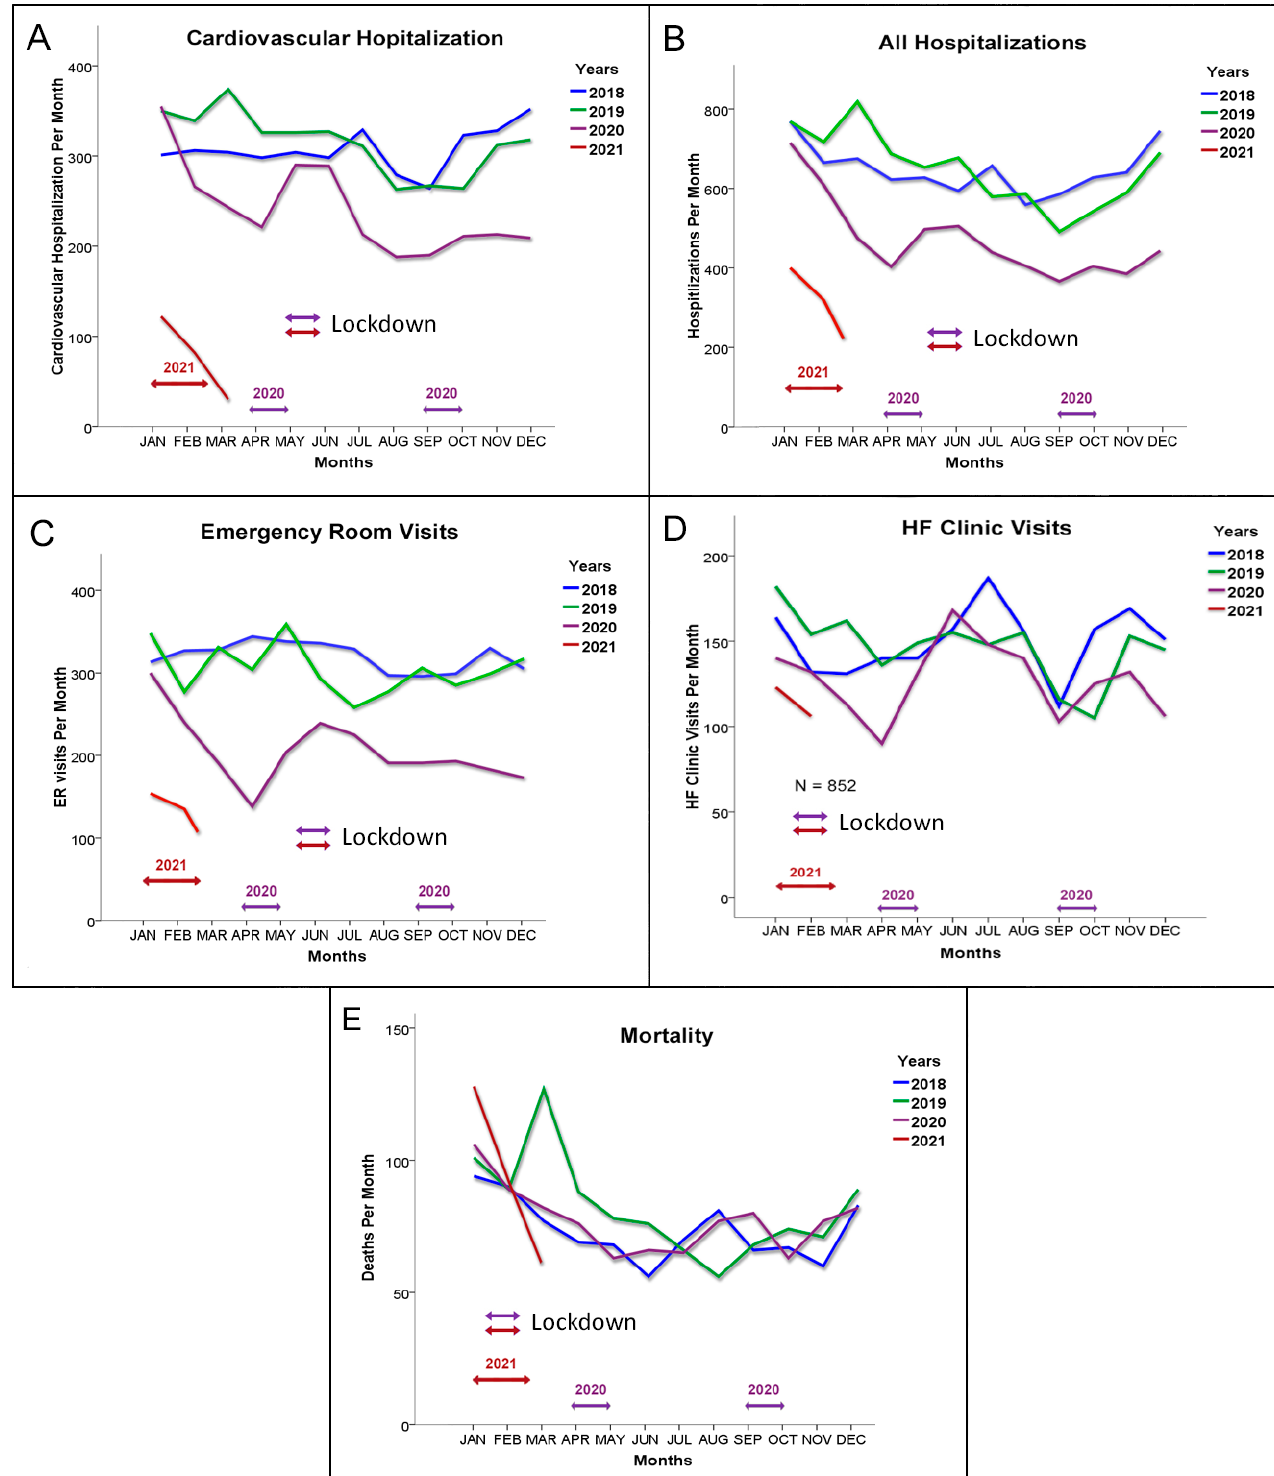
Figure 2. Health service usage during the pandemic compared to the two years prior to the pandemic. Data are presented as total numbers per month. ( A ) Cardiovascular hospitalizations. ( B ) All hospitalizations. ( C ) Emergency room visits. ( D ) HF clinic visits. Data are from the 852 patients followed at the Clalit health maintenance organization heart failure center in Jerusalem. ( E ) Mortality rates per month in the HF cohort.